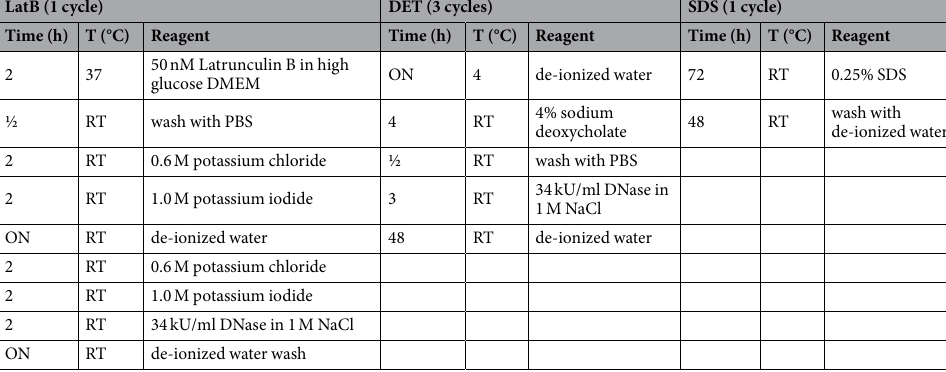
Table 1. Summary of the three decellularisation protocols. LatB, Latrunculin B protocol; DET, Detergent Enzymatic Treatment; SDS, Sodium Dodecyl Sulfate protocol; ON, over night; T, temperature; RT, room